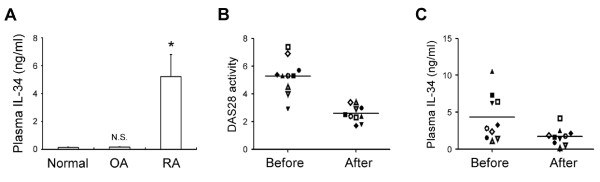
Correlation between interleukin-34 (IL-34) levels and inflammation in rheumatoid arthritis (RA) patients. (A) IL-34 levels were determined in plasma of healthy controls (normal), OA or RA patients by n enzyme-linked immunosorbent assay (ELISA) (*P < 0.05, N.S., not significant, compared to normal). (B) and (C) Plasma was collected from individual RA patients (n = 10) and the same patients were administrated disease-modifying anti-rheumatic drugs (DMARDs) and followed-up for 1 year. Disease Activity Score 28 (DAS28) activity (A) and IL-34 levels (ELISA) (B) were determined for each patient in plasma samples collected before and after administration of DMARDs. Symbols indicate individual data points; horizontal bars show group means (P < 0.01, after versus before DMARDs administration).